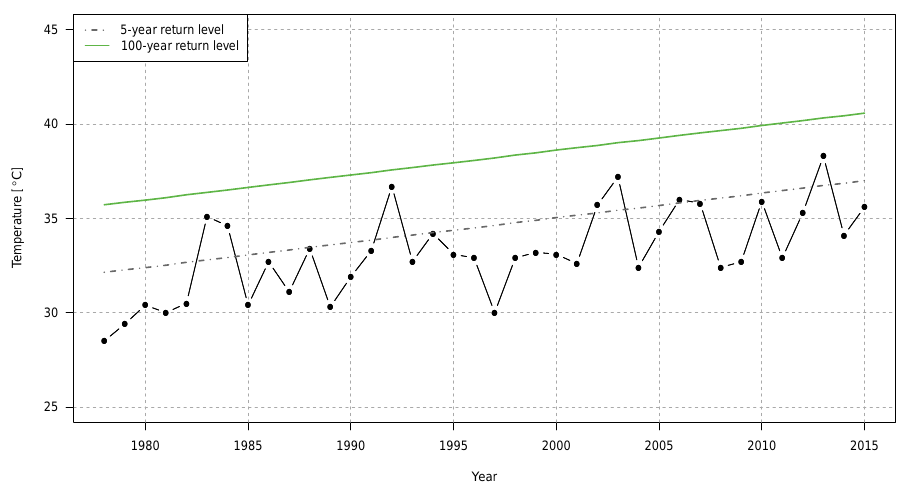
Figure 2. Return level plot of temperature maxima at Pörtschach (Carinthia) with linear trend correction. The trend is visible in the lines depicting the 5-year return level (gray dashed line) and the 100-year return level (green solid line). This is an illustrative example of tem- perature trends that are commonly observed at the selected stations for both temperature maxima (increasing trend) and temperature minima (decreasing trend).